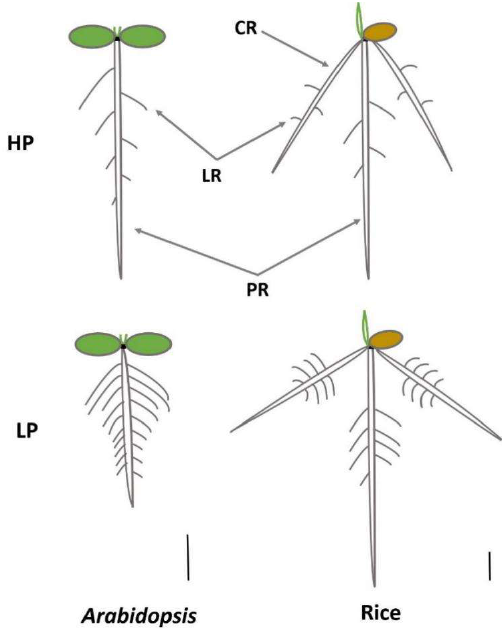
Figure 1. Schematic representation of a typical allorhizic (left) and secondary homorhizi (right) root system grown in HP (upper) and LP (lower), exemplified by Arabidopsis and rice. Shallow and deep root systems were formed in LP or HP, respectively. Shorter PR length, longer length and higher density of LR and root hair were formed for Arabidopsis in LP; Larger CR growth angle and longer length and higher density of root hair were developed for rice in LP. PR—primary root; LR—lateral root; CR—crown root; HP—high phosphate conditions; LP—low phosphate conditions. Scale bars, 1 cm.